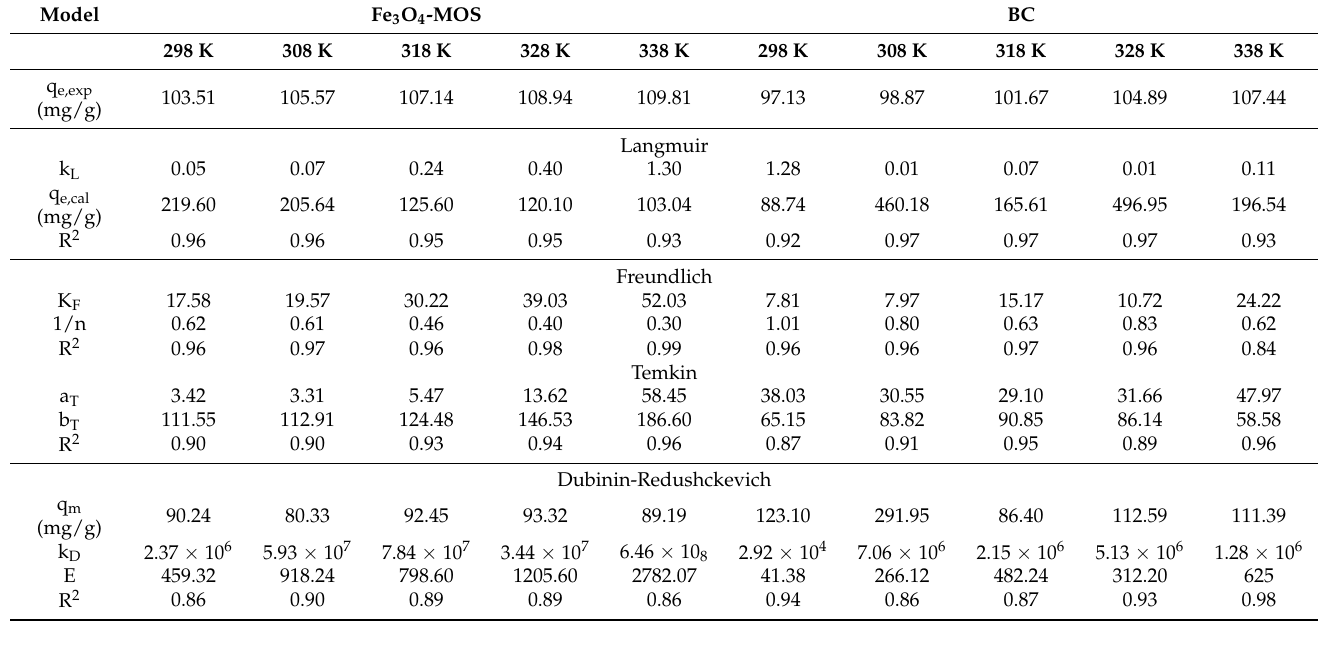
Table 3. The parameters of the isothermal model for adsorption of MB onto Fe 3 O 4 -MOS and BC.